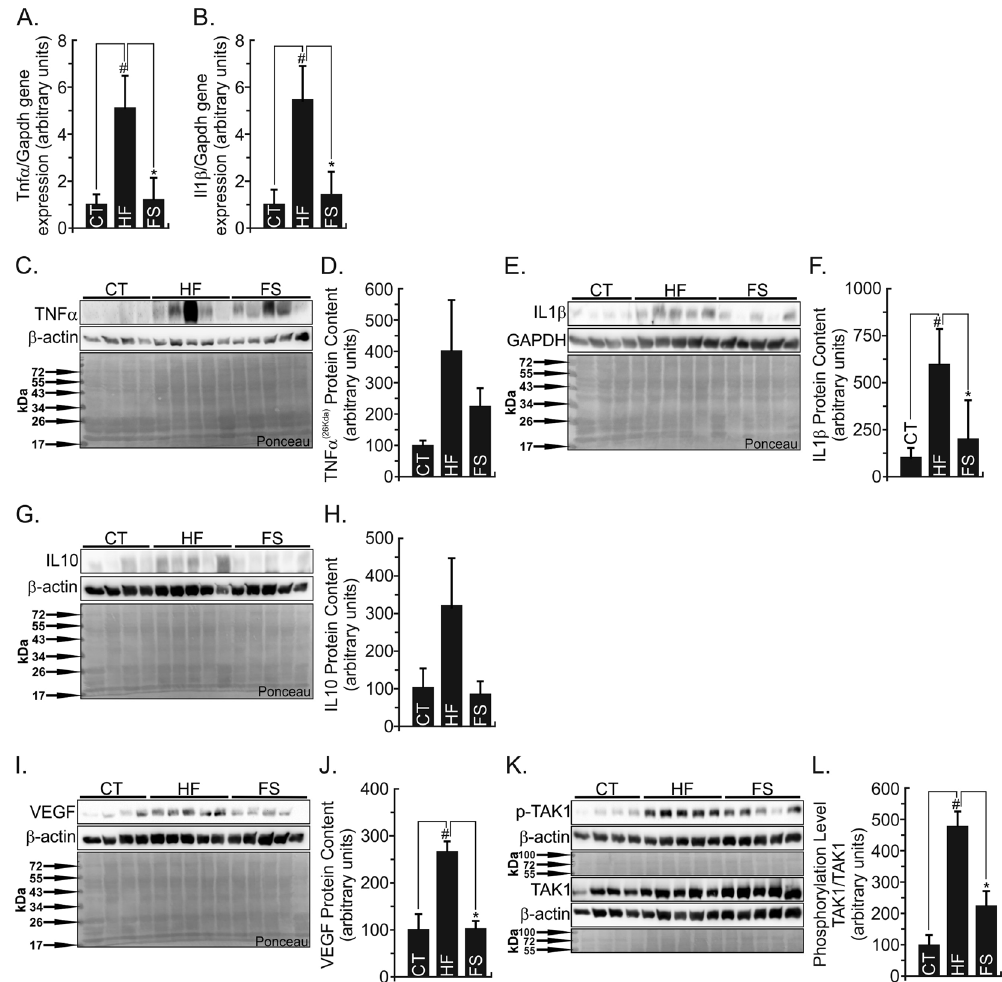
Figure 5. Inflammatory and Retinopathy Gene and Protein Markers. ( A,B ) Total RNA obtained from retina was used in real-time q-PCR to amplify the mRNAs of TNF α (A) and IL1 β ( B ). Gapdh was adopted as an internal control. n = 5. Protein extracts obtained from the retina of Swiss mice were used in immunoblotting (IB) experiments, to evaluate pro- and anti-inflammatory protein contents. Specific antibodies against TNF α ( C,D ), IL1 β ( E,F ), IL10 ( G,H ), VEGF ( I,J ), and phosphor- TAK1 ( K,L ). Loading was evaluated by